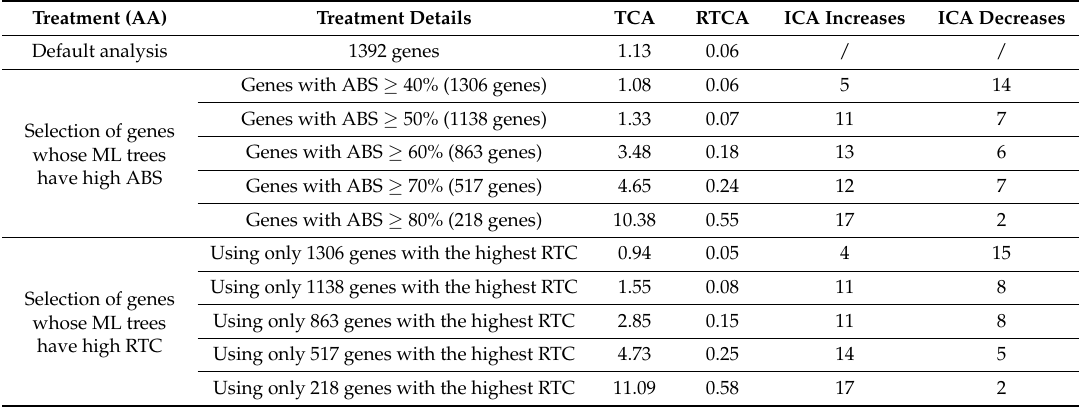
Table 3. Differences in holometabolous phylogenies inferred from different phylogenomic practices for amino